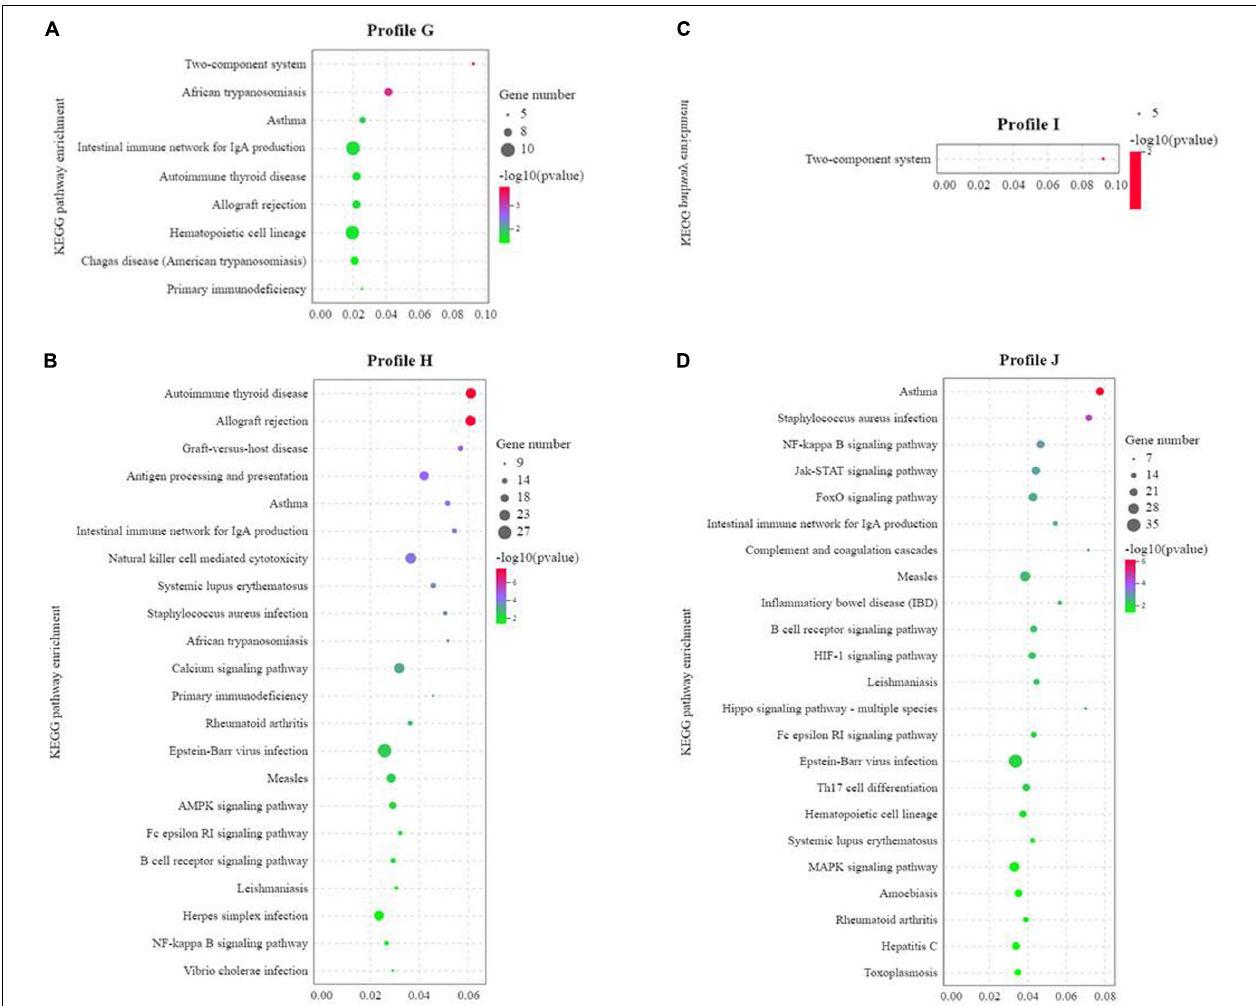
FIGURE 9 | Kyoto Encyclopedia of Genes and Genomes (KEGG) enrichment analysis of the significantly differentially expressed genes (DEGs) of the three soy protein substitutes for fish meal in the distal intestine of the pearl gentian grouper ( n = 4). (A) The KEGG enrichment analysis of the common differential genes in SBM40, SPC40, and FSBM40 groups. (B) The KEGG enrichment analysis of the unique differential genes in SBM40 group. (C) The KEGG enrichment analysis of the unique differential genes in SPC40 group. (D) The KEGG enrichment analysis of the unique differential genes in FSBM40